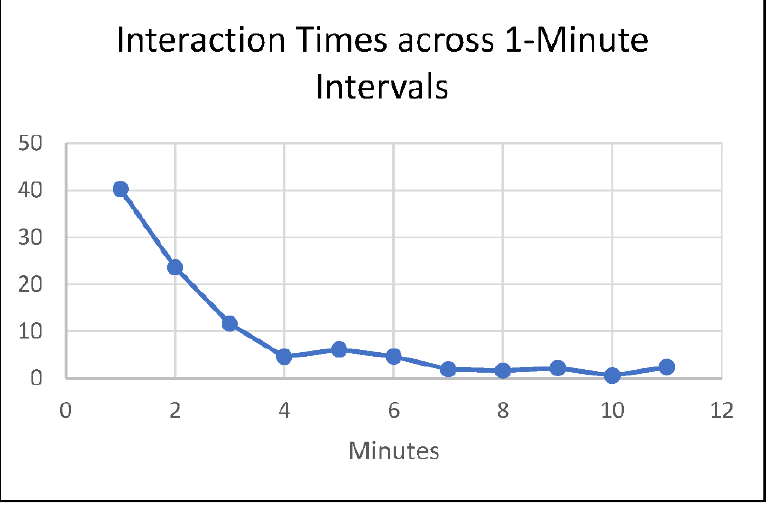
Figure 5. Distribution of interaction times across 1 min intervals.